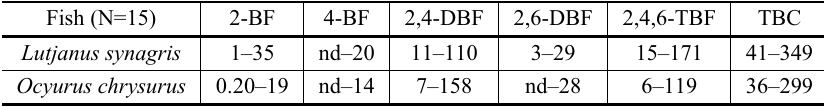
Range of bromophenol concentrations (ng g –1 ) found in muscle.